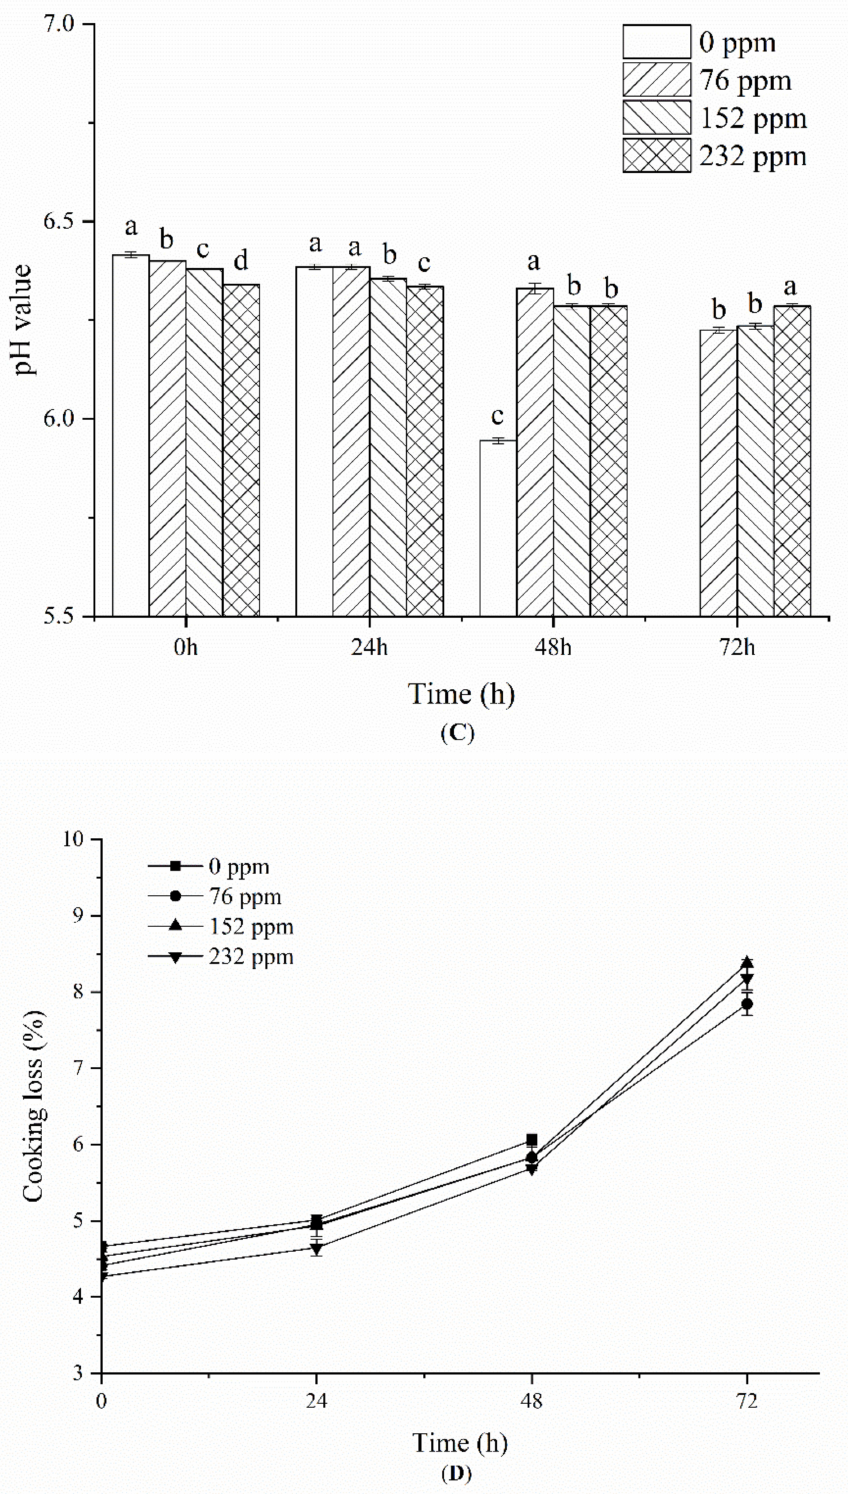
Figure 3. Effect of chlorine dioxide gas treatment on the microbial growth ( A ), L* value ( B ), pH value ( C ) and cooking loss ( D ) in FBNs during storage. Different lowercase letters indicate significant differences at p <